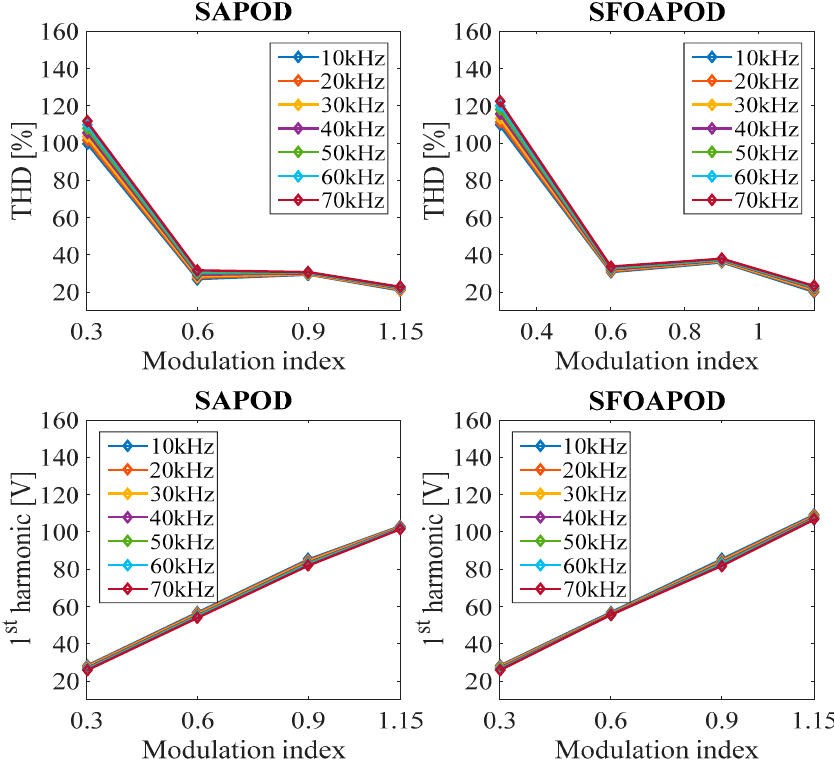
Figure 16. Experimental THD% and fundamental amplitude trends of SAPOD and SFOAPOD schemes.